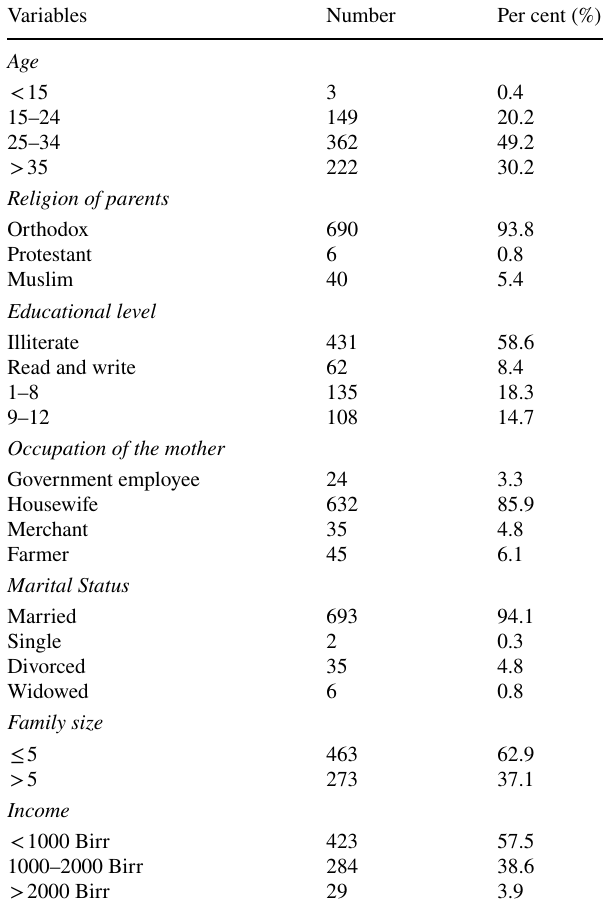
Table 1 Distribution of socio-demographic characteristics of respondents in North Gondar Zone, 2016 ( n =